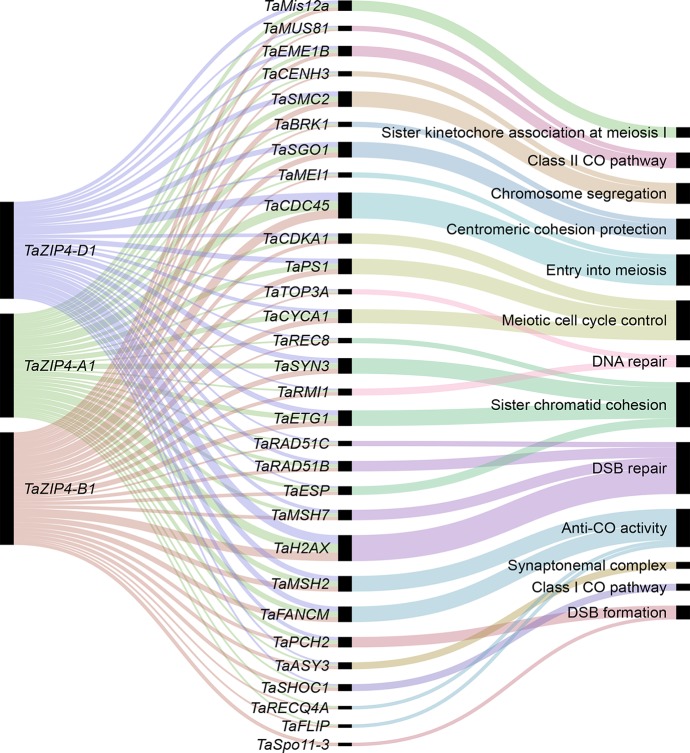
The wheat MG orthologs connected to TaZIP4. The alluvial diagram shows the connected genes to the TaZIP4 homeologs TaZIP4-A1, TaZIP4-B1, and TaZIP4-D1. Edge weight > 1 was used as threshold to visualize connected genes. Black bars indicate the number of homeologs for each connected gene.